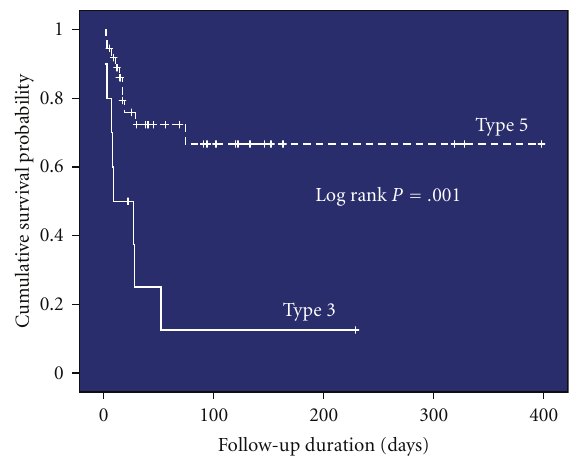
Figure 2: Kaplan-Meier survival curves showing significantly better survival in Type 5 compared to Type 3 cardiorenal syndrome (72.3% versus 12.5%).